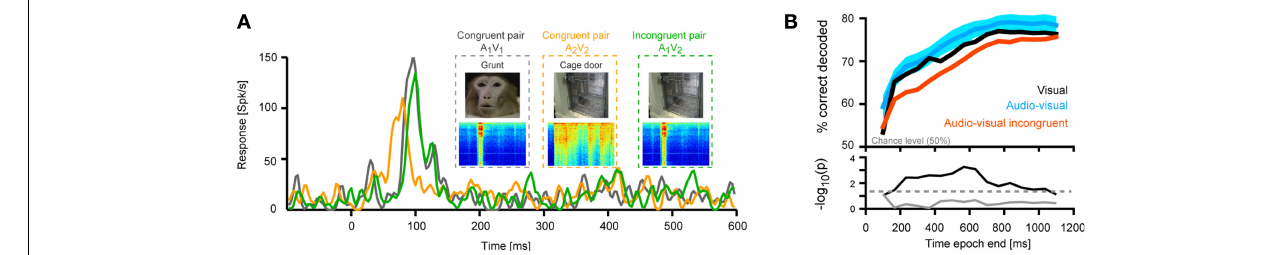
FIGURE 4 | Decoding of different visual scenes. (A) Response of one example unit to two different congruent bimodal audio-visual pairs (conspecifi c vocalization and cage door being opened) and one incongruent combination. (B) Performance in discriminating two different visual scenes presented either as unimodal visual stimuli, congruent bimodal pairs or two visual scenes presented in the same acoustic context. For decoding the full time course of the response sampled at 20 ms was considered. The graphs display decoding performance as a function of the response interval